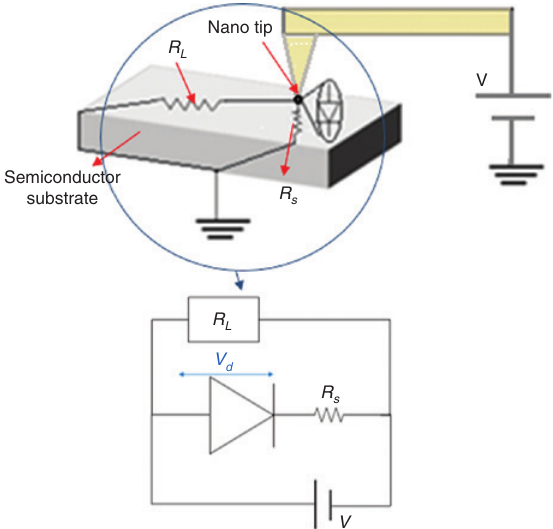
Figure 9: A schematic showing a nano-tip in contact with a semi- conductor substrate and the contribution of series resistance and surface resistance with an equivalent circuit representation.